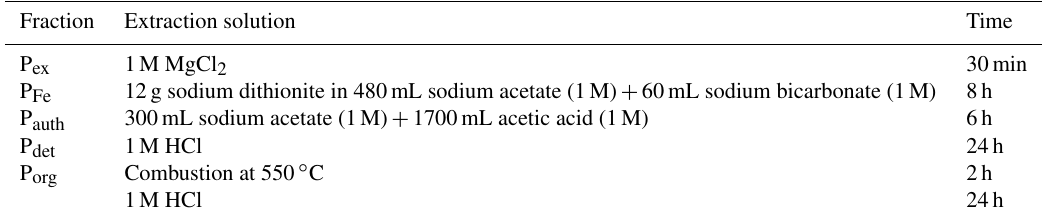
Table 1. Specifics for the sequential extractions of phosphorus. A brief summary of the reagents, methods, and times used for SEDEX. Each step was followed by a wash with 1M MgCl 2 (pH 8) for 30min to avoid re-adsorption of